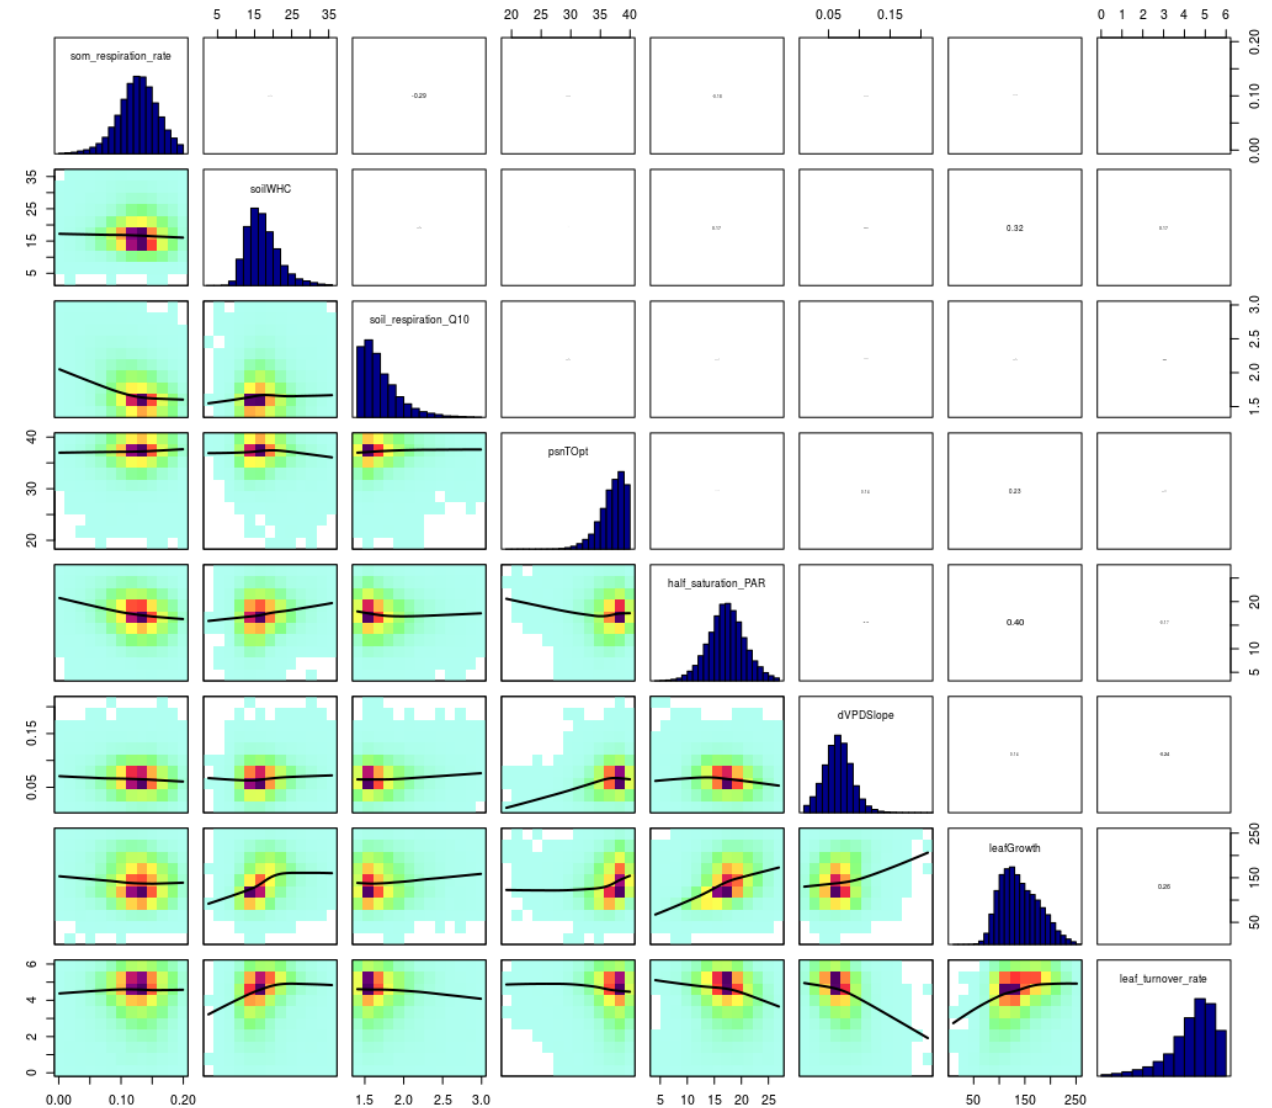
Figure A3. Correlations in the posterior samples after emulator MCMC (SIPNET). The lower left and upper right triangles show the corre- lation density and the Pearson correlation coefficients between the parameters on the diagonal, respectively (Hartig et al.,